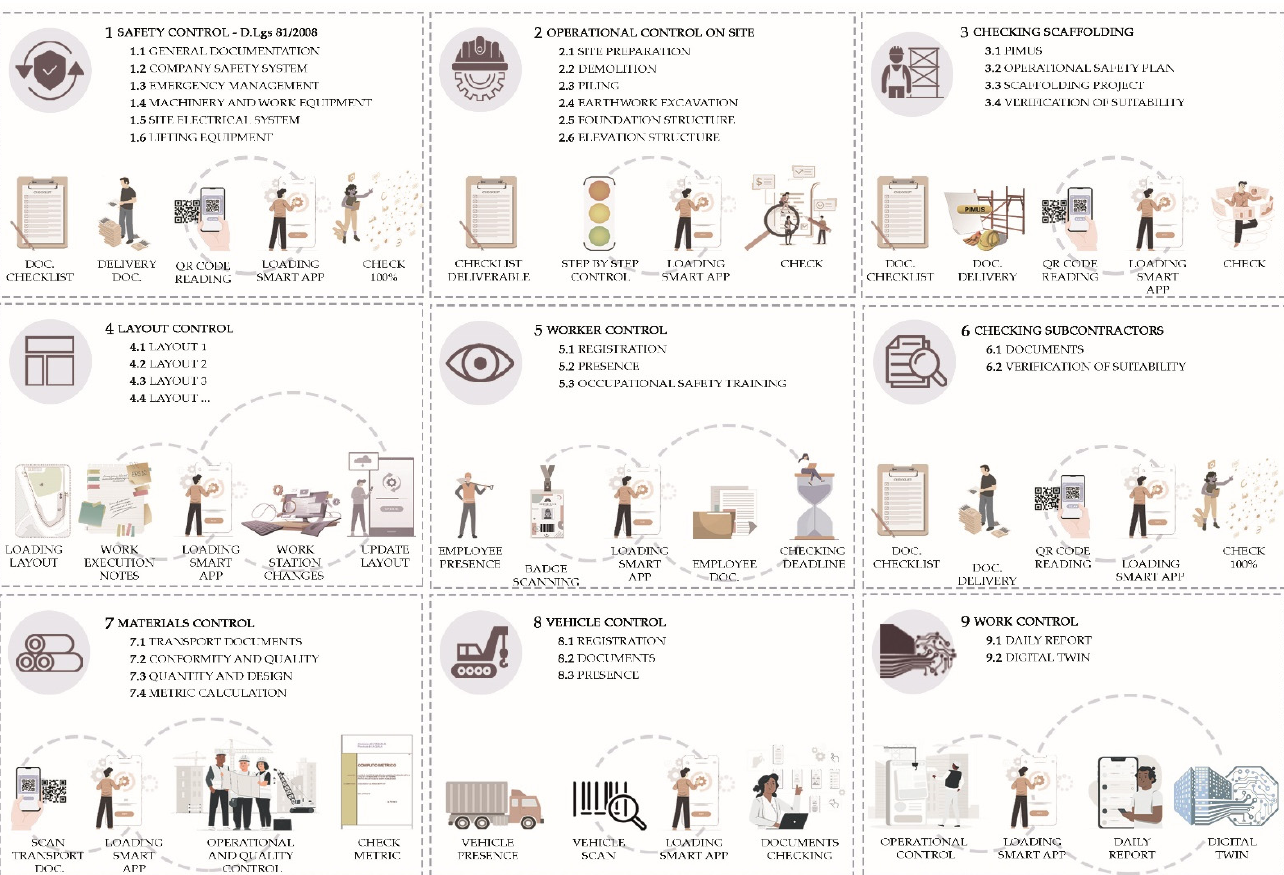
Figure 2. Operational control on construction site - SmartApp.